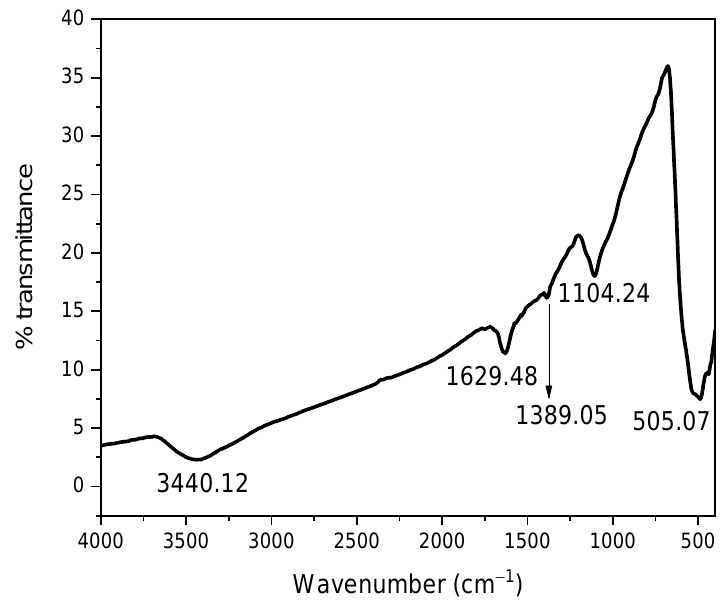
Figure 6. FTIR spectrum of CuO NPs.